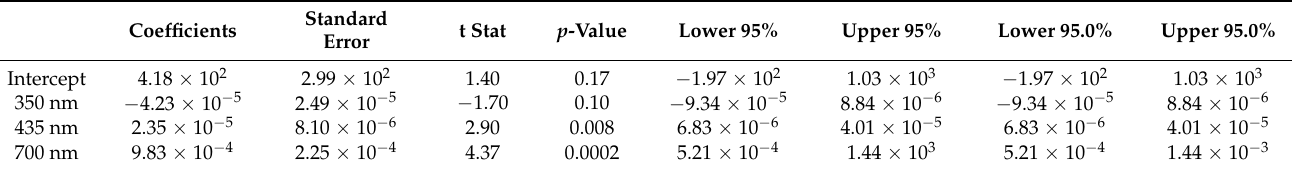
Table 3. Regression table